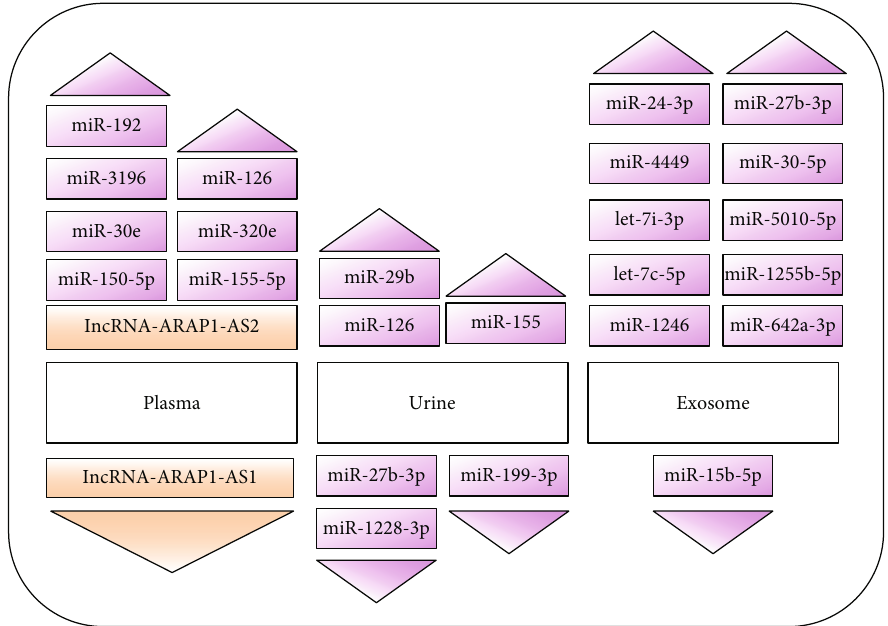
Figure 2: ncRNAs in plasma, urine, and exosome as a new biomarker in DN. Purple represents miRNAs, and orange represents